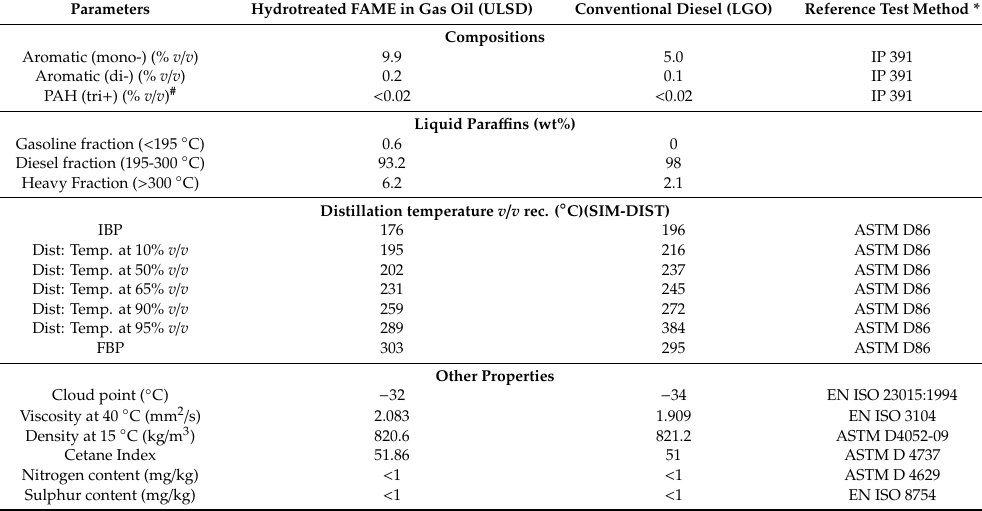
Table 1. Physical properties and chemical composition of the hydrotreated and commercial diesel provided by Preem AB, Sweden. IBP—Initial Boling Point; FBP—Final Boiling Point; # polyaromatic hydrocarbon (PAH) (tri + ) should be less than 0.02% with diesel grade. * Samples were analysed at Preem refinery laboratory, Gothenburg, Sweden under the similar test methods adapted earlier [2,4,5]. Parameters Hydrotreated FAME in Gas Oil (ULSD) Conventional Diesel